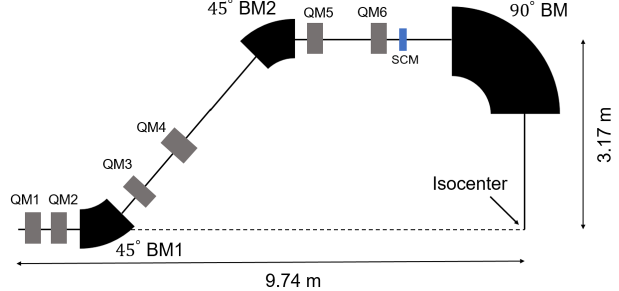
FIG. 1. Layout of the CIRT gantry. QM: quadrupole magnet; BM: bending magnet. The radius from the rotational axis to the beam axis is 3.17 m. The radius from the rotational axis to the outer part of the iron shielding is 3.83 m.